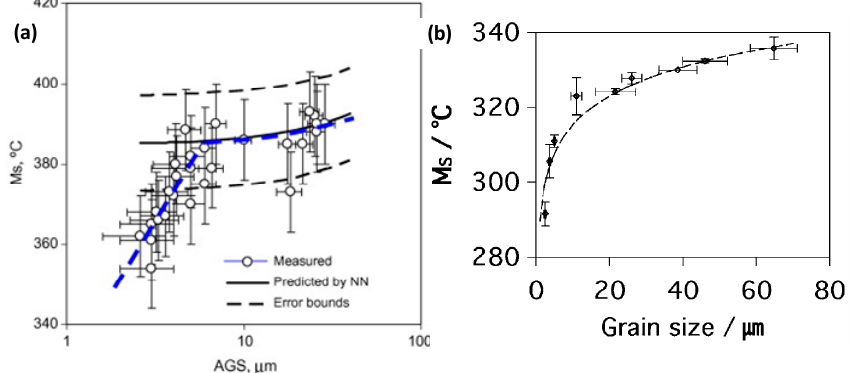
Figure 6. Influence of prior austenite grain size (PAGS) on the Ms temperature ( a ) comparison of experimental results and those obtained by a Neural Network model from reference [39]. Reproduced with permission from Elsevier, 2017. And ( b ) experimental work from reference [40]. Reproduced with permission from Elsevier, 2017.